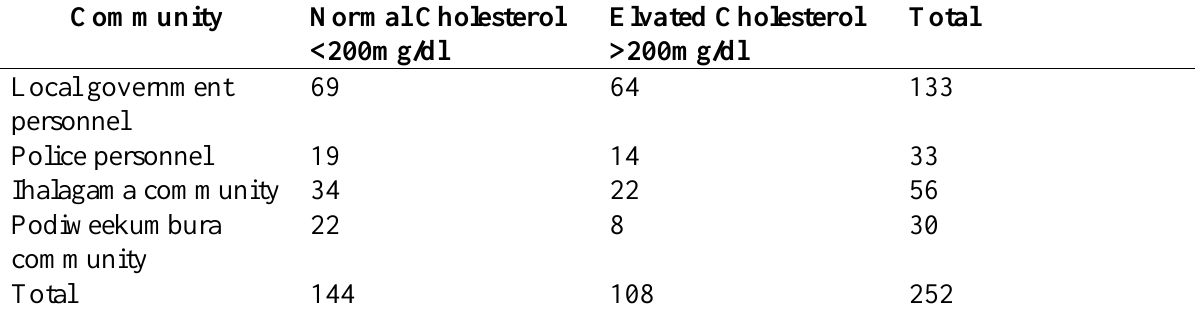
Table 1: Status of serum cholesterol levels of selected residents of MOH area Ragama Community